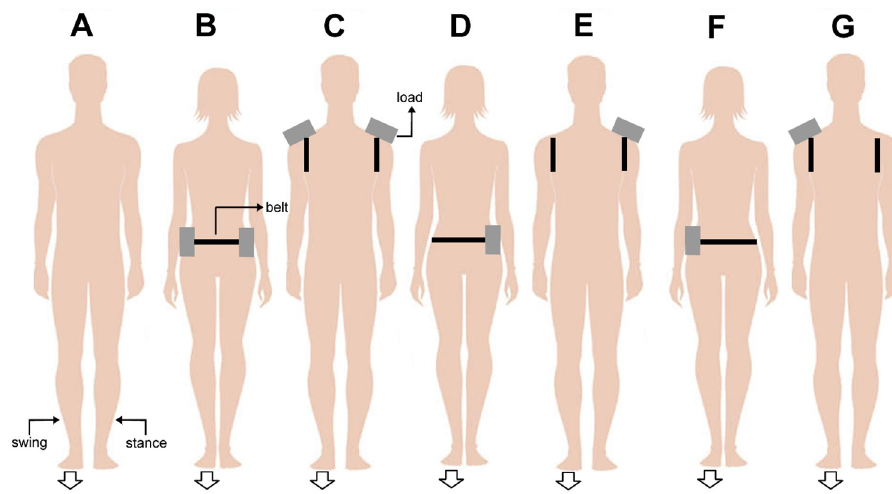
Fig 1. Schematic representation of experimental conditions: (A) no load (NL), (B) waist uniformly distributed load (WUD), (C) shoulder uniformly distributed load (SUD), (D) waist stance foot load (WST), (E) shoulder stance foot load (SST), (F) waist swing foot load (WSW), and (G) shoulder swing foot load (SSW). The arrow indicates the foot used to start the movement (swing foot).